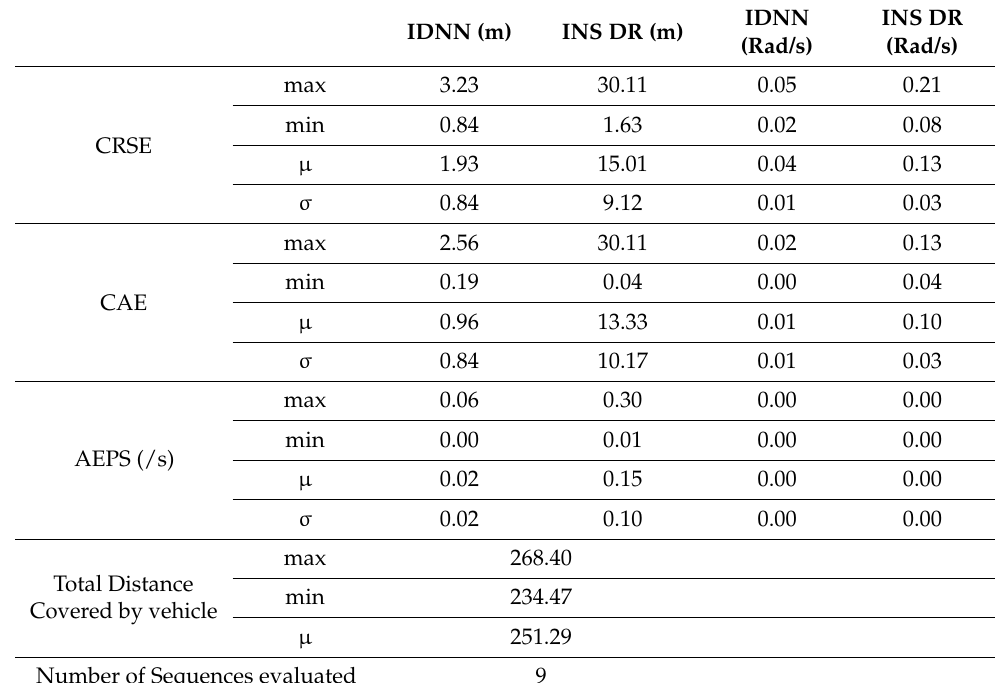
Table 8. Showing the performance of the IDNN and dead reckoned Inertial Navigation Systems (INS